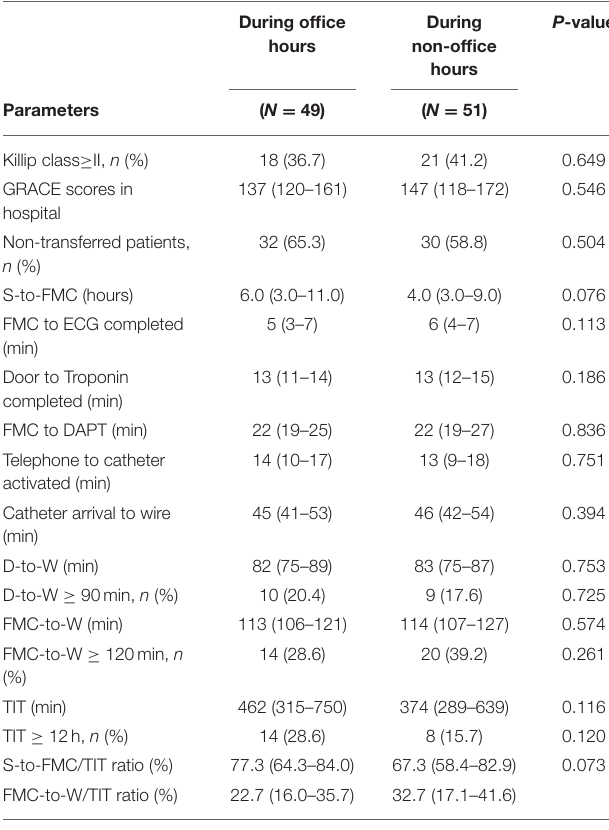
TABLE 2 | Comparison of PPCI parameters between different arrival periods during COVID-19